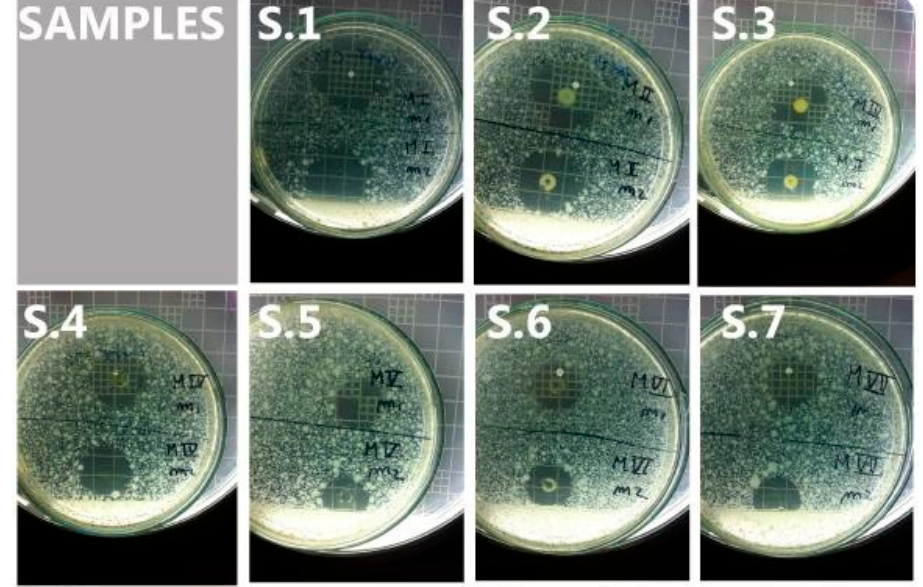
Figure 2. Results from microbiological screening for residues of CTC and 4-epi-CTC in chicken droppings. Plates S1 to S7 represent sampling points 1 to 7. Each sampling point was assessed on duplicate samples (i.e., two cylinders were placed on each plate). Hence, the values for the halo diameter at each sampling point represent the average of these duplicate samples. On average, inhibition halos measured 2.2, 2.2, 2.0, 1.7, 1.4, 1.2, and 1.3 cm, respectively.